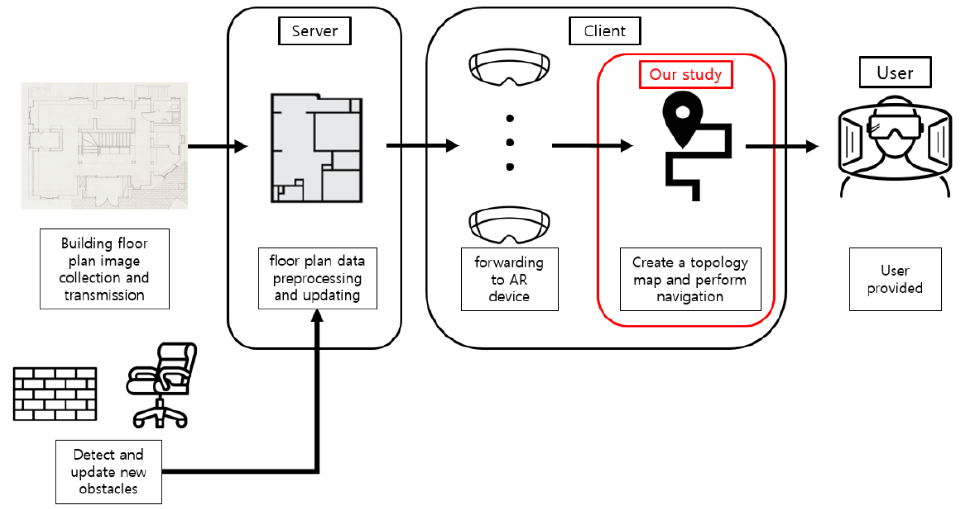
Figure 1. Navigation System Architecture for AR HMD.